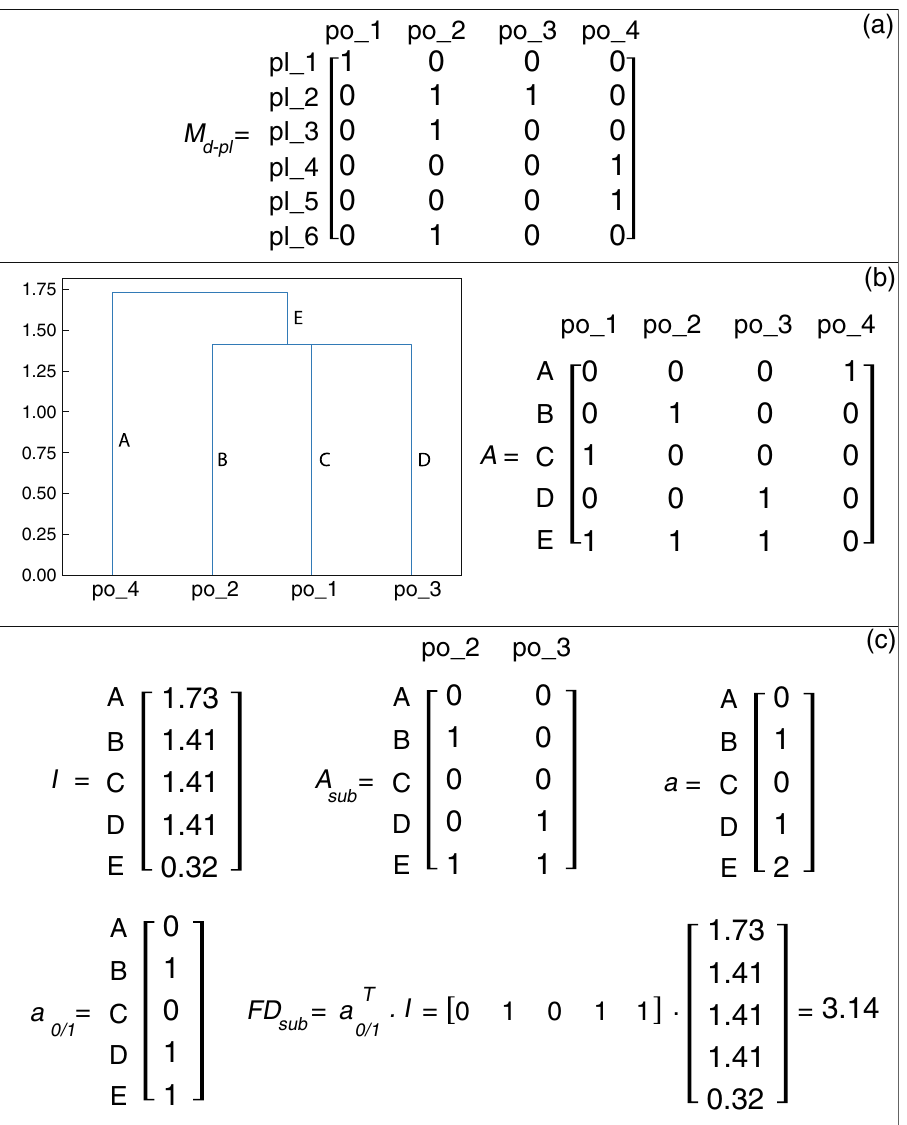
Figure 14. An example illustrating the calculation of functional diversity for a subset of a community for a network that consists of 25 plant and 25 pollinator nodes using linear algebra. This network reduces to 6 plant and 4 pollinator nodes after simplification. ( a ) Demonstrates the directed adjacency matrix M d − pl containing the binary information on the edges incoming to plant nodes. ( b ) Shows the dendrogram resulted when the matrix M d − pl was used for clustering. There are five branches labeled with letters A through E. The functional diversity of any subset of the dendrogram is equal to the sum of the branch lengths (considering the branches from the base of the dendrogram) of that subset. For example, the branch length corresponding to po_1 is the sum of the lengths of branches C and E. To calculate functional diversity of a sub community using algebra, first we calculate the distribution matrix, which denotes the distribution of branches in each pollinator. For instance, po_1 goes through branches C and E to reach the base of the dendrogram. As a result, rows C and E are equal to 1 under column po_1. ( c ) Illustrates the last final steps to cal; vector I denotes the length of each branch, and matrix A sub denotes the sub-matrix of A that only involves po_2 and po_3 (assume an example in which only po_2 and po_3 survive among pollinators). Then vector a which is the sum of the columns of A sub is constructed and converted to a binary vector a 0 / 1 . Functional diversity of the survived community is then equal to the transposed a 0 / 1 multiplied by the vector I